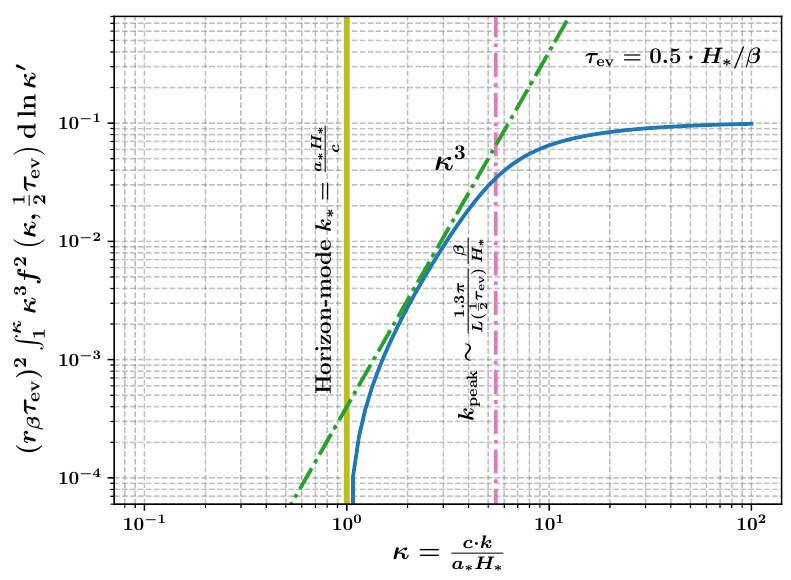
. The yellow line ev